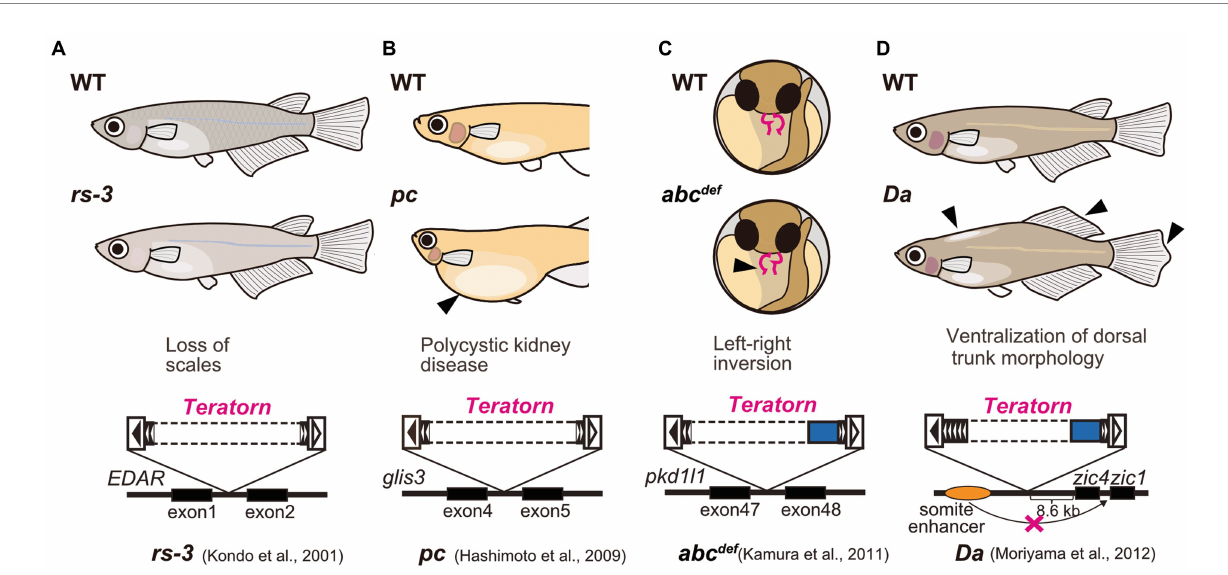
FIGURE 1 Medaka spontaneous mutants caused by Teratorn insertion. (A) rs-3 mutant [loss of scales, (28)]. (B) pc mutant [polycystic kidney disease, (29)] (C) abc def mutant [defect in left–right axis formation, (30)]. (D) Da mutant [ventralization of dorsal trunk morphology, (31)]. Solid and dotted boxes inside Teratorn indicate the sequence-determined and undetermined region,